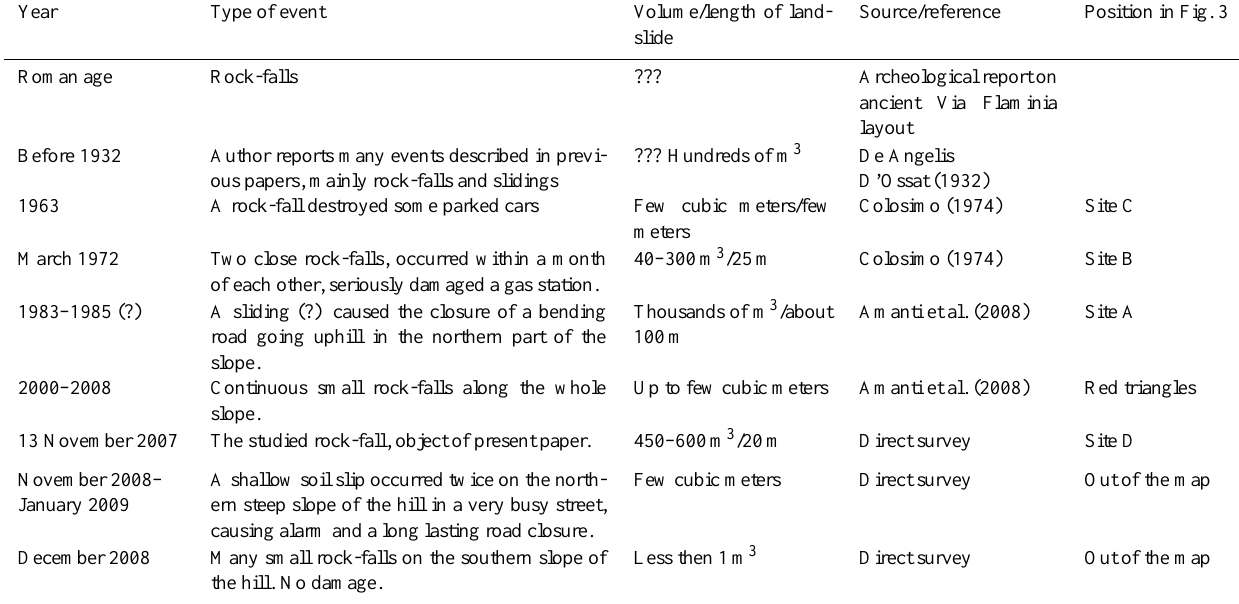
Table 1. Overview on past landslide